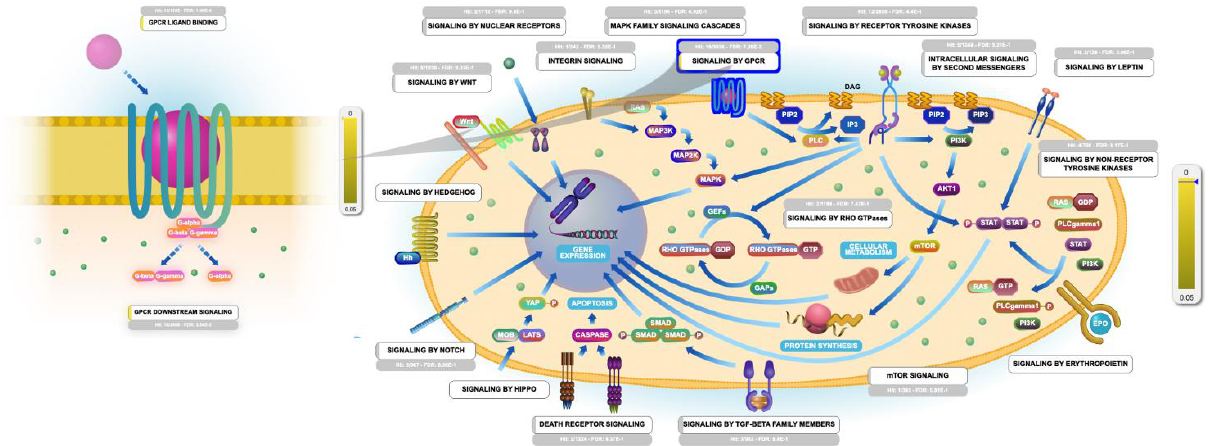
Figure 10. Graphic representation of the Reactome pathways influenced as a response to erylosides B (226) in term of SARS-CoV-2 infection. The representation showing the G-protein coupled receptor (GPCR) signaling pathway as the most enriched pathway influenced by erylosides B (226) treatment in the human genome.